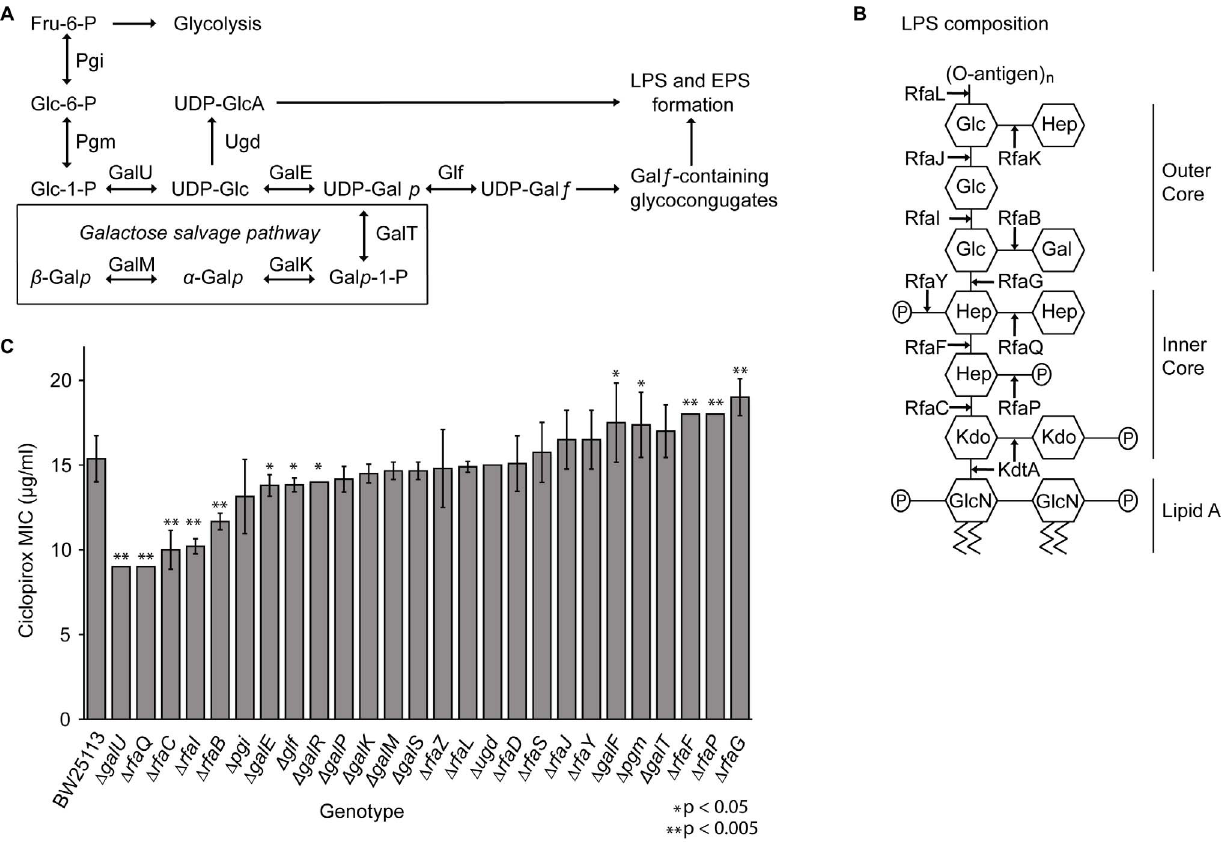
Figure 6. Effect of ciclopirox on strains involved in the galactose and lipopolysaccharide biosynthesis pathways. (A) Schematic representations of the galactose salvage pathway, (B) LPS biosynthesis pathway proteins for E. coli K-12 strain. Note the O-antigen is not present in K- 12 strains, but is depicted for reference for where the O-antigen can attach. Abbreviations include fructose (Fru), glucose (Glc), galactose (Gal), heptose (Hep), N -acetylglucosamine (GlcN), 3-deoxy- D - manno -oct-2-ulopyranosonic acid (Kdo), and phosphate (P). (C) Ciclopirox MICs for Keio parent, BW25113, and single gene Keio deletion strains were measured in three independent cultures. These genes encode enzymes involved in the galactose metabolism and LPS biosynthesis pathways. Student’s t-test was used to assess